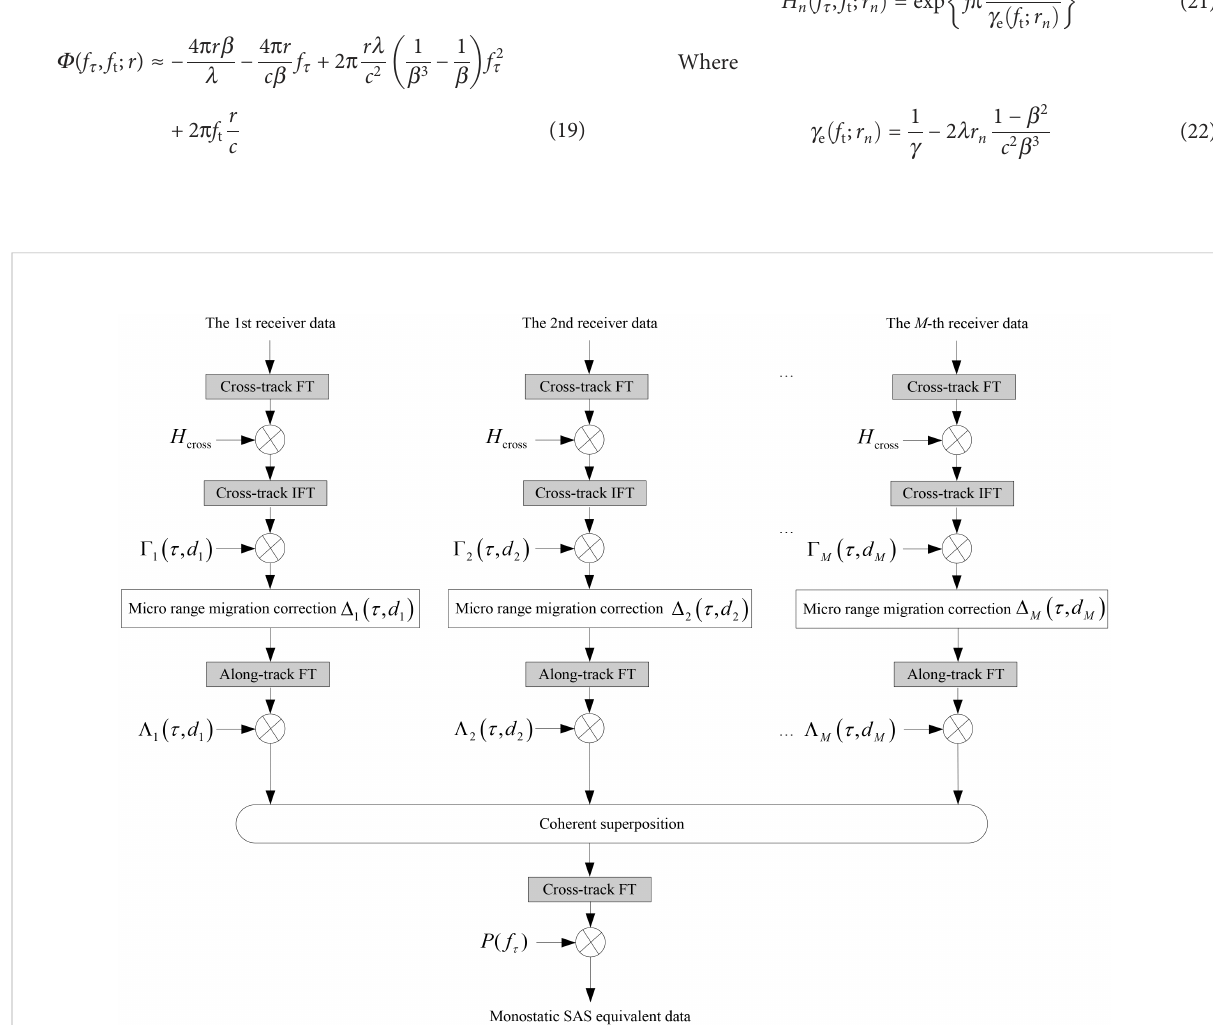
FIGURE 2 Block diagram of multiple-receiver synthetic aperture sonar (MSAS)